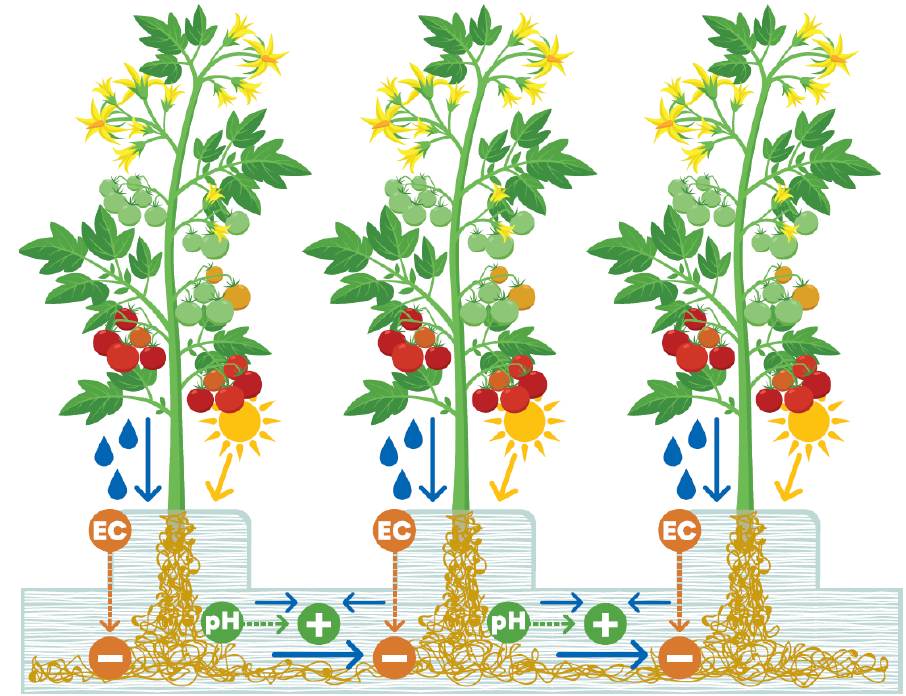
Figure 3. Rockwool growing medium as a microbial habitat, illustrating the flow of irrigation (blue arrows) and gradients of EC and pH, which are repeated throughout the glasshouse. arrows) and gradients of EC and pH, which are repeated throughout the